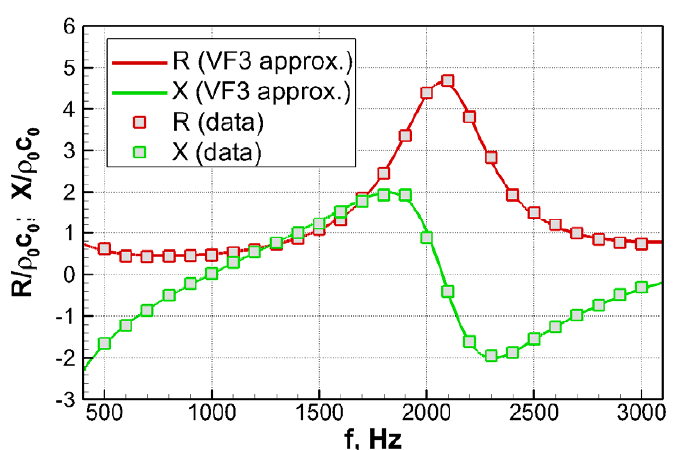
Figure 6. Frequency-dependence of acoustic resistance R and reactance X of the CT57 liner from experiment [14] and its VF-approximation by multipole function.